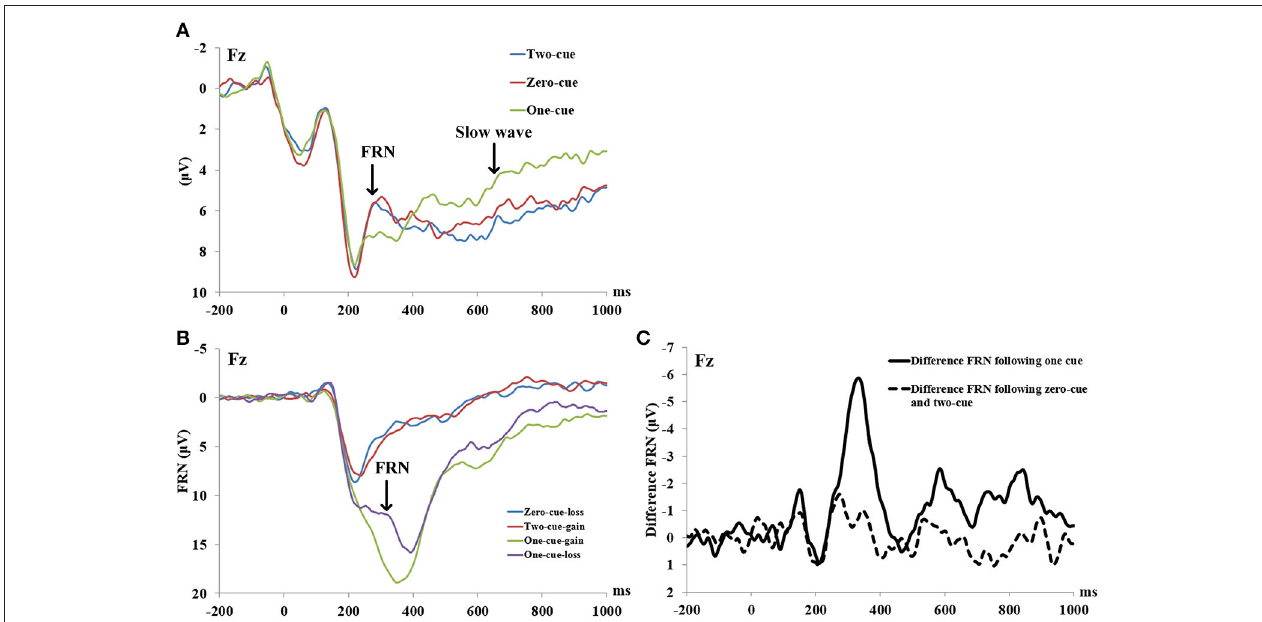
FIGURE 1 | (A) ERP waveforms during the cue period at electrodes Fz. Cue onset was at 0 ms. (B) ERP waveforms during the outcome evaluation period at electrodes Fz. The feedback onset was at 0 ms. (C) Difference waves during the outcome evaluation period at electrodes Fz. The feedback onset was at 0ms.